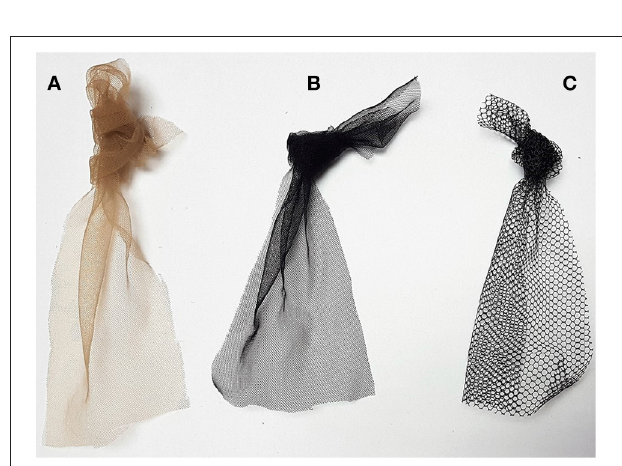
FIGURE 2 | Fabric samples. (A) T1 sample. (B) T2 sample. (C) T3